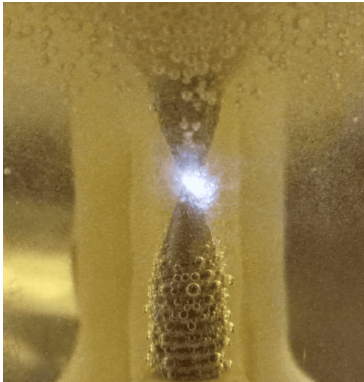
Figure 14. Plasma formation inside the electrolysis